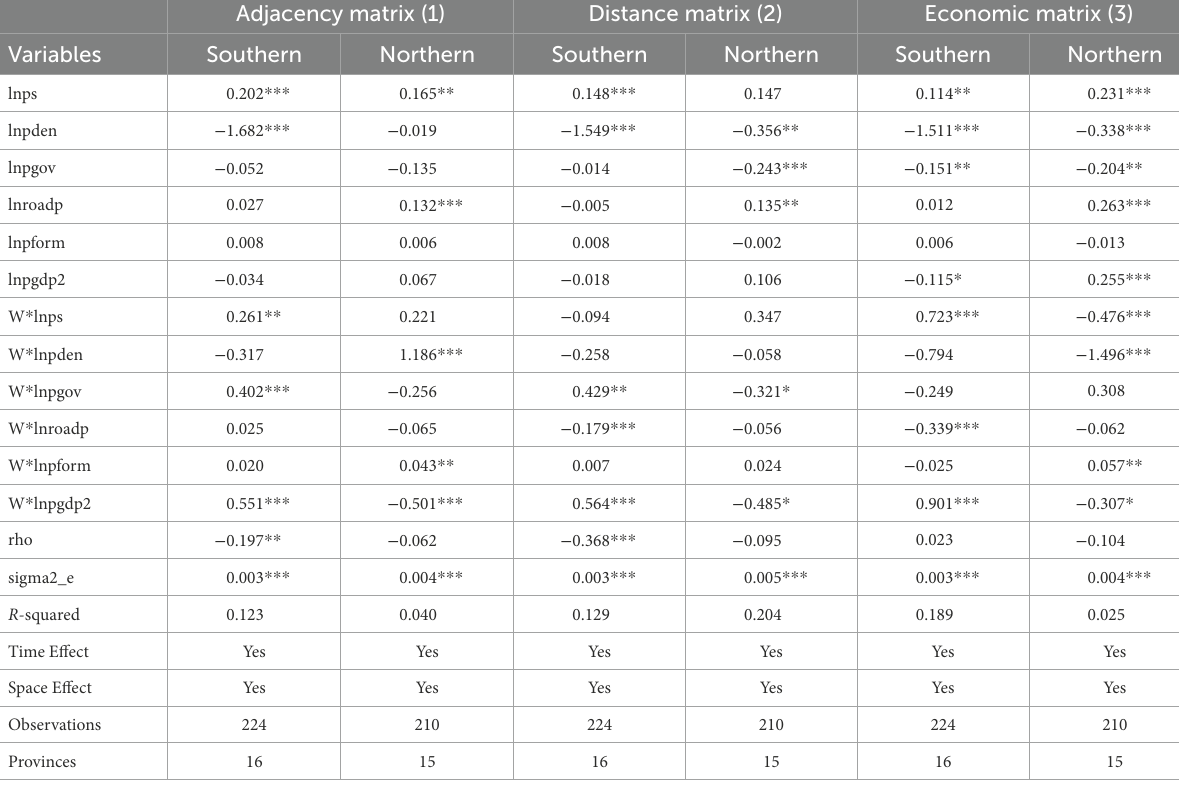
TABLE 6 Spatial regression results of per capita GDP of the tertiary industry in north and south